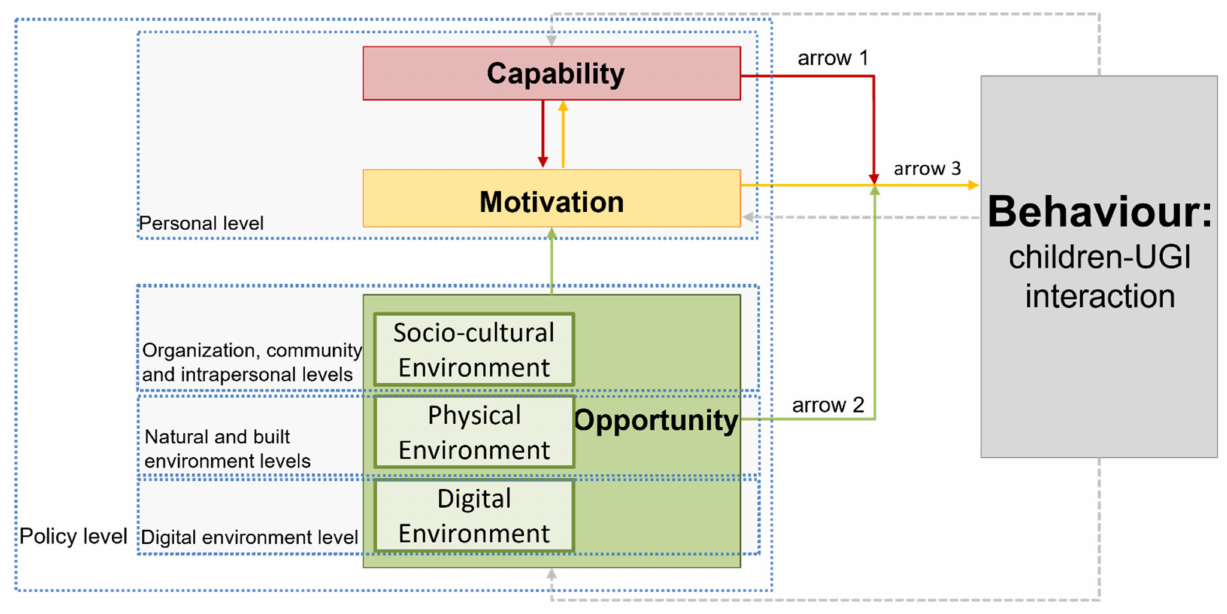
Figure 1. The suggested conceptual model of children–UGI interaction determinants that brings together the COM-B model [10] and the social-ecological model [8] while including the role of digital environment